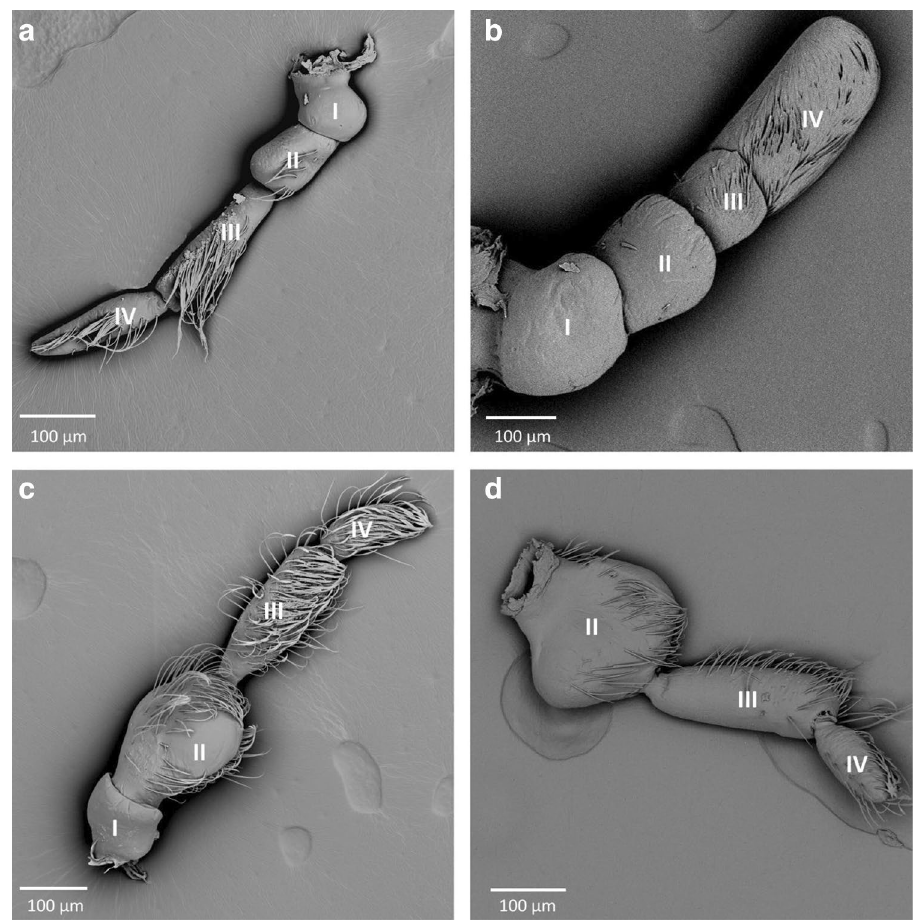
Figure 1. The antennae of Cheirochelinae and Laccocorinae; ( a ) Asthenocoris austrialis , ( b ) Gestroiella limnocoroides , ( c ) Heleocoris strabus , ( d ) Laccocoris sp.; I–IV—numbers of